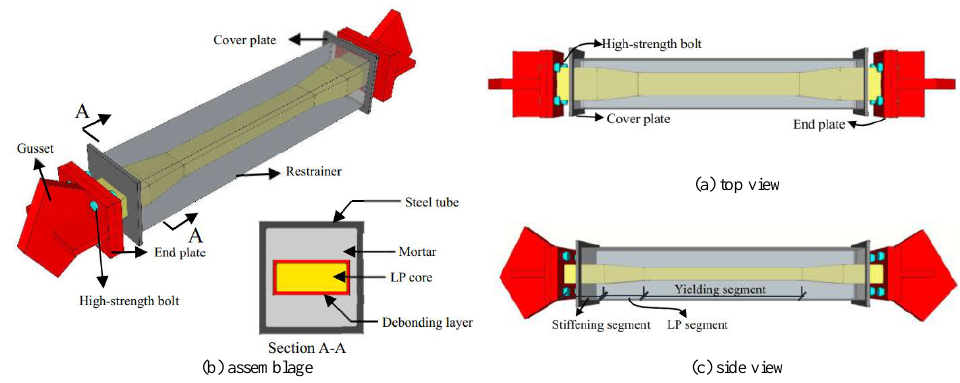
Figure 1. LPBRB configuration.